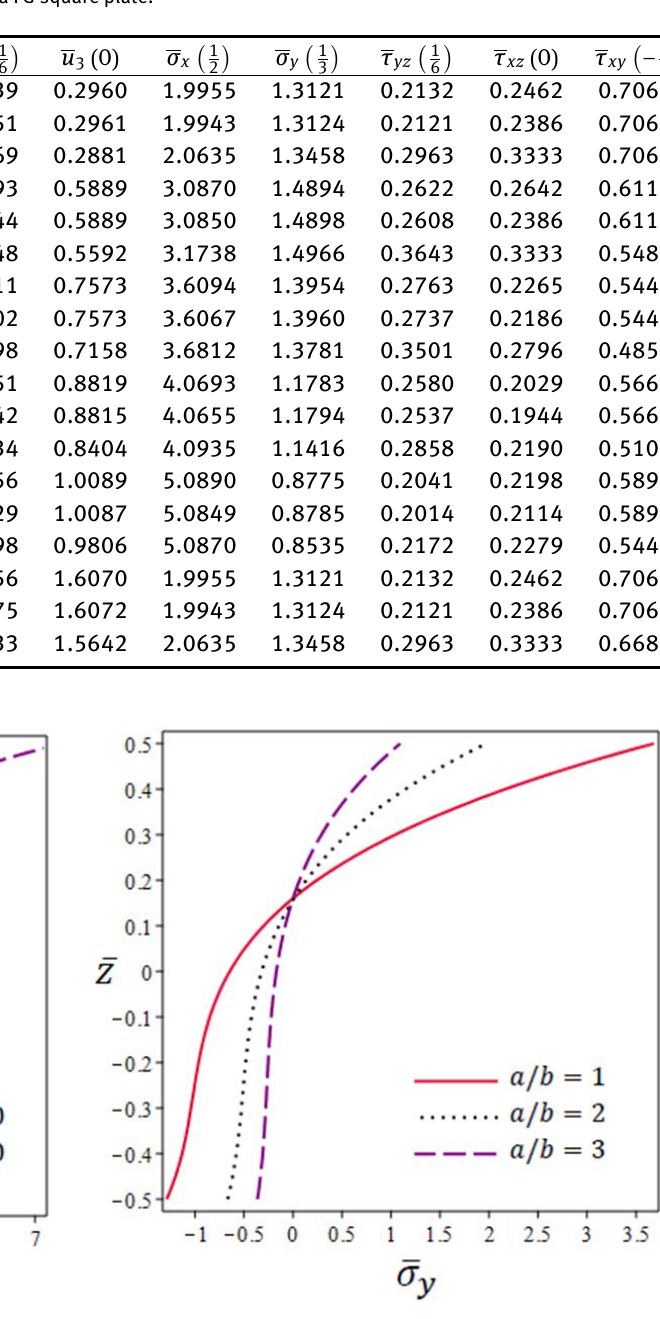
Table 2: The non-dimensional displacements and stresses of a FG square plate.